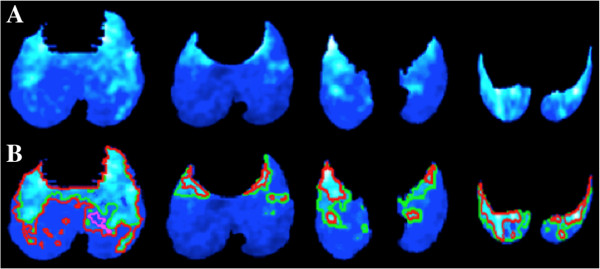
Segmentation variations by 5% difference in threshold values. (A) Multiple PET axial image slices from a rabbit with an active lung infection are shown for demonstration purpose (color code: cold). Areas of light color indicate higher PET intensities, while areas of darker color signify background, noise, or uptake belonging to minimum metabolism. (B) Two locally adaptive threshold levels outline areas of interesting uptake regions. Here, only a 5% difference in thresholding level is shown by green and red (i.e., pink outline is the inner boundaries of red outline), respectively.